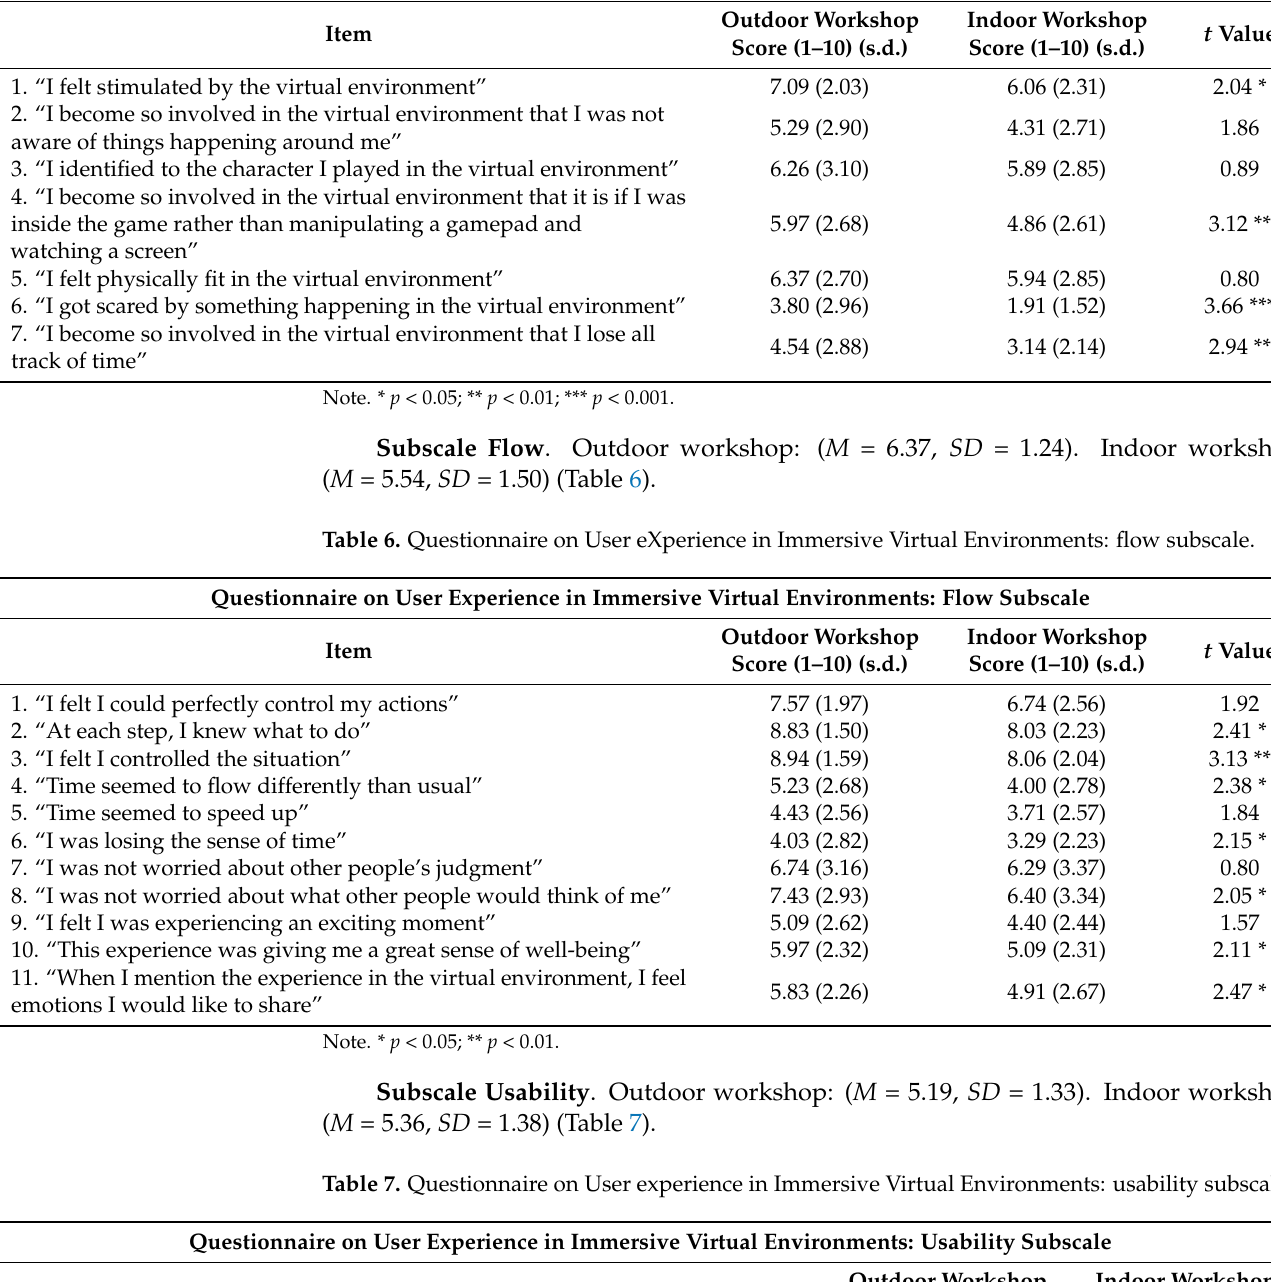
Table 5. Questionnaire on User eXperience in Immersive Virtual Environments: immersion subscale. Questionnaire on User Experience in Immersive Virtual Environments: Immersion Subscale